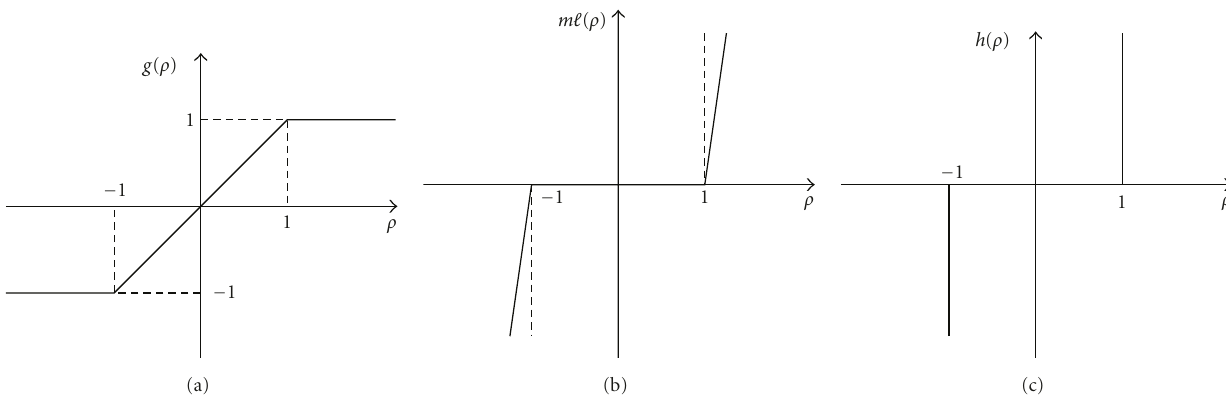
Figure 2: Nonlinearities used in the CNN models (S), (I), and